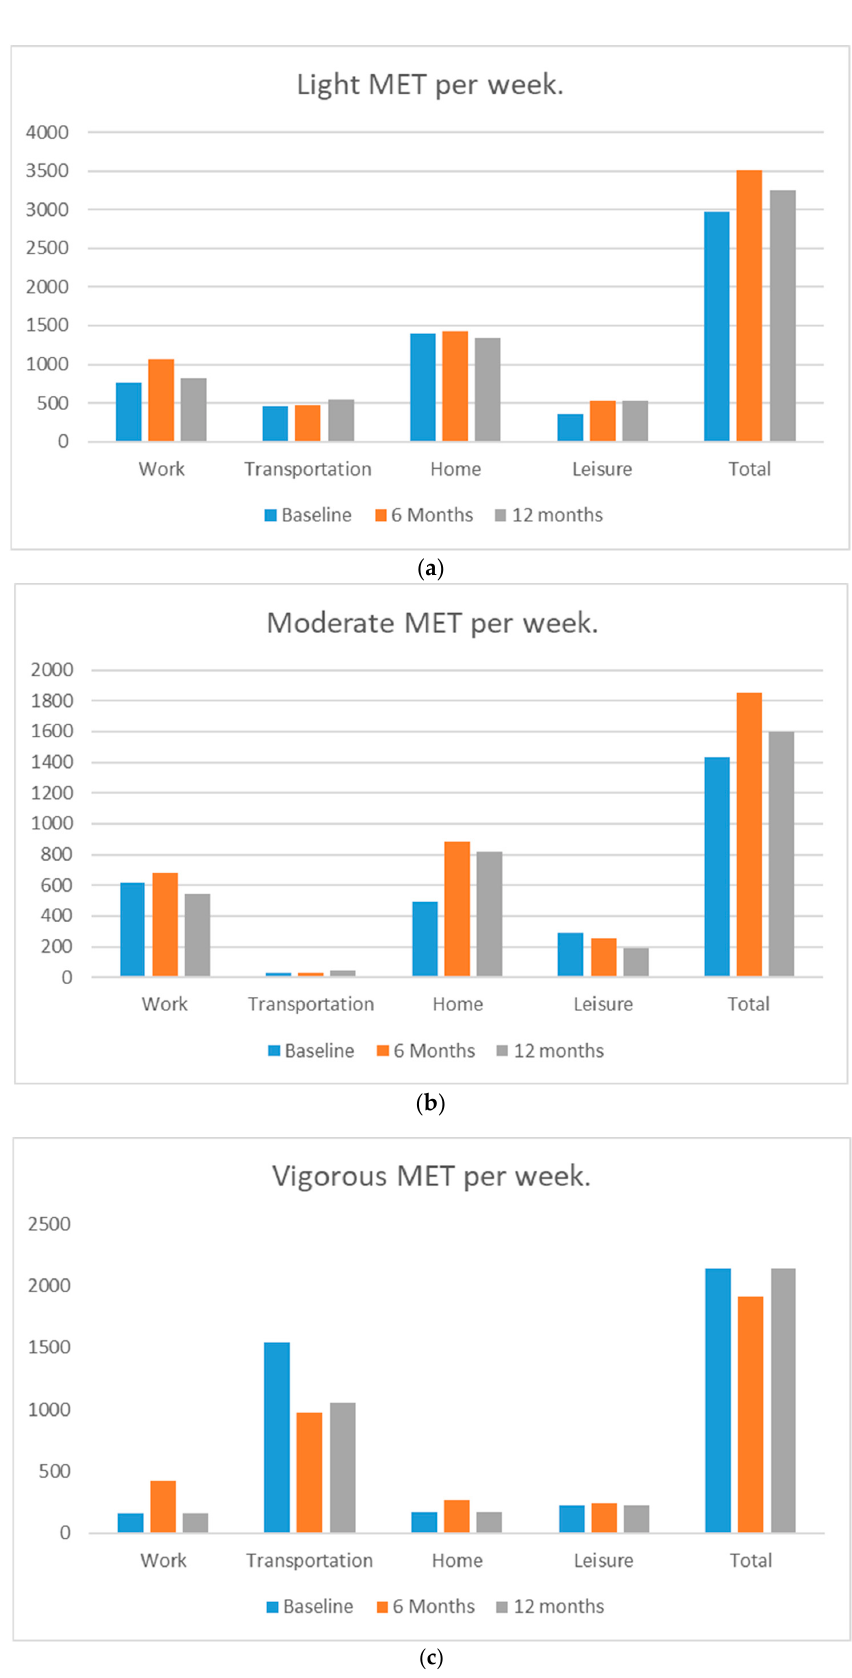
Figure 1. MET minutes per week of light, moderate, and vigorous physical activity. ( a ) Light MET per week; ( b ) moderate MET per week; and ( c ) vigorous MET per week.